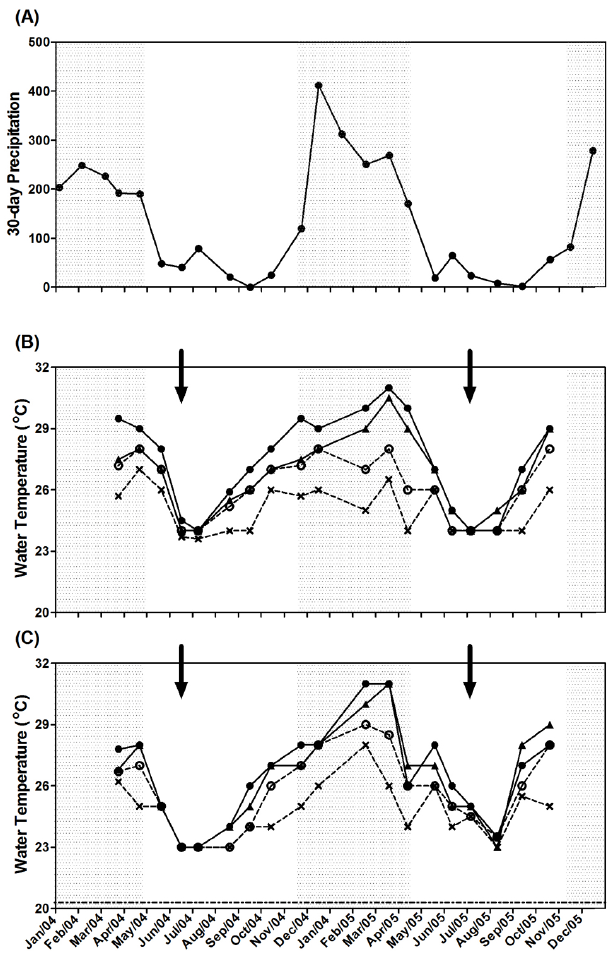
Fig. 2. Monthly fluctuations in 30-day precipitation (A) and wa- ter temperature in Lake Barra (B) and Lake Aguap´e (C) during 19 months from March 2004 to October 2005. Four depths were sampled in the morning assuming the light penetration in lake wa- ters: 100% (unbroken line, filled circle), 10% (unbroken line, filled triangle), 1% (dashed line, open circle), and 0% (dashed line, crosses). See material and methods for details on the determina- tion of each sampling depth. Arrows point to the thermal mixing events during the dry season at the beginning of the winter (2004 and 2005), and the dotted frames indicate the rainy seasons (be- tween 2004 and 2005) in each